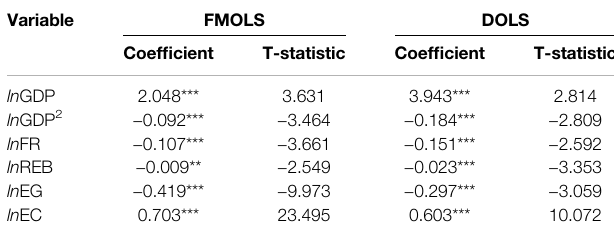
TABLE 8 | FMOLS and DOLS test results (Robustness